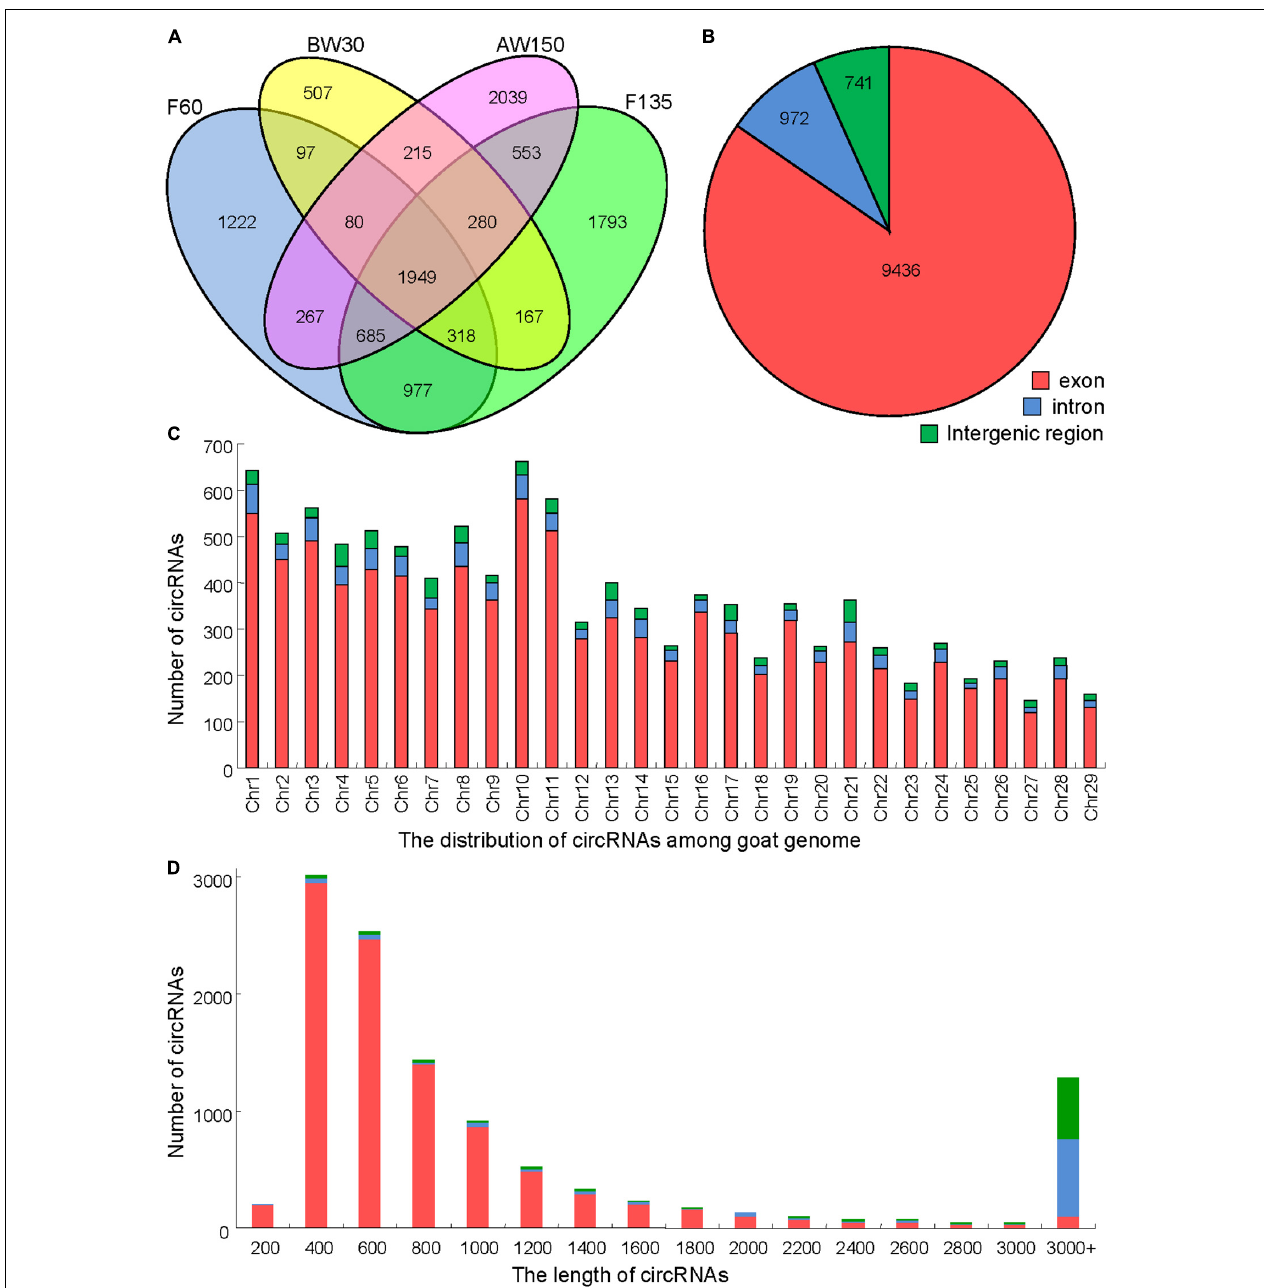
FIGURE 2 | Properties of circRNAs in goat rumen tissue samples. (A) Venn diagram showing the number of circRNAs either shared between or uniquely expressed in goat rumen tissues during fetal and prepubertal periods. (B) Pie chart showing the prevalence of different circRNA types. circRNAs from introns are represented by the orange section, while the blue region indicates circRNAs from exons. (C) Distribution of circRNAs on the chromosomes of the goat reference genome. (D) Lengths of the